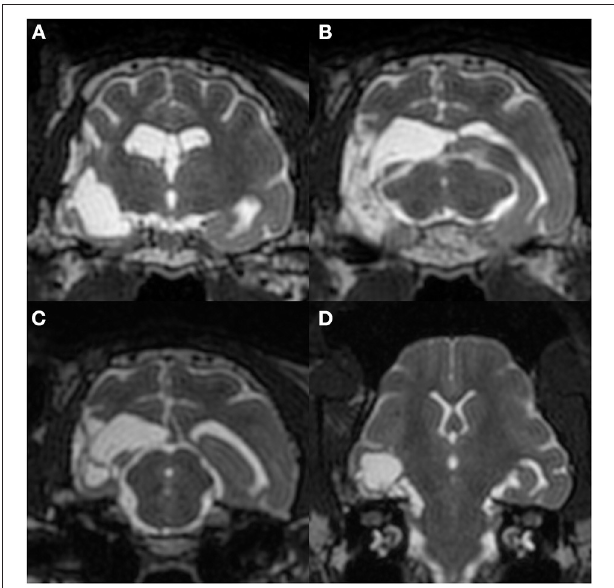
FIGURE 10 | Postoperative MRI at 60 days after the 2nd surgery. Transverse T2-weighted images at the hippocampal head (A) , medial geniculate body ( B ; matching Figure 2 ), and rostral colliculus (C) , and a dorsal image perpendicular to the long axis of the hippocampus (D) . The right hippocampus and a part of the temporo-occipital cortex had been removed without apparent surrounding signal changes.